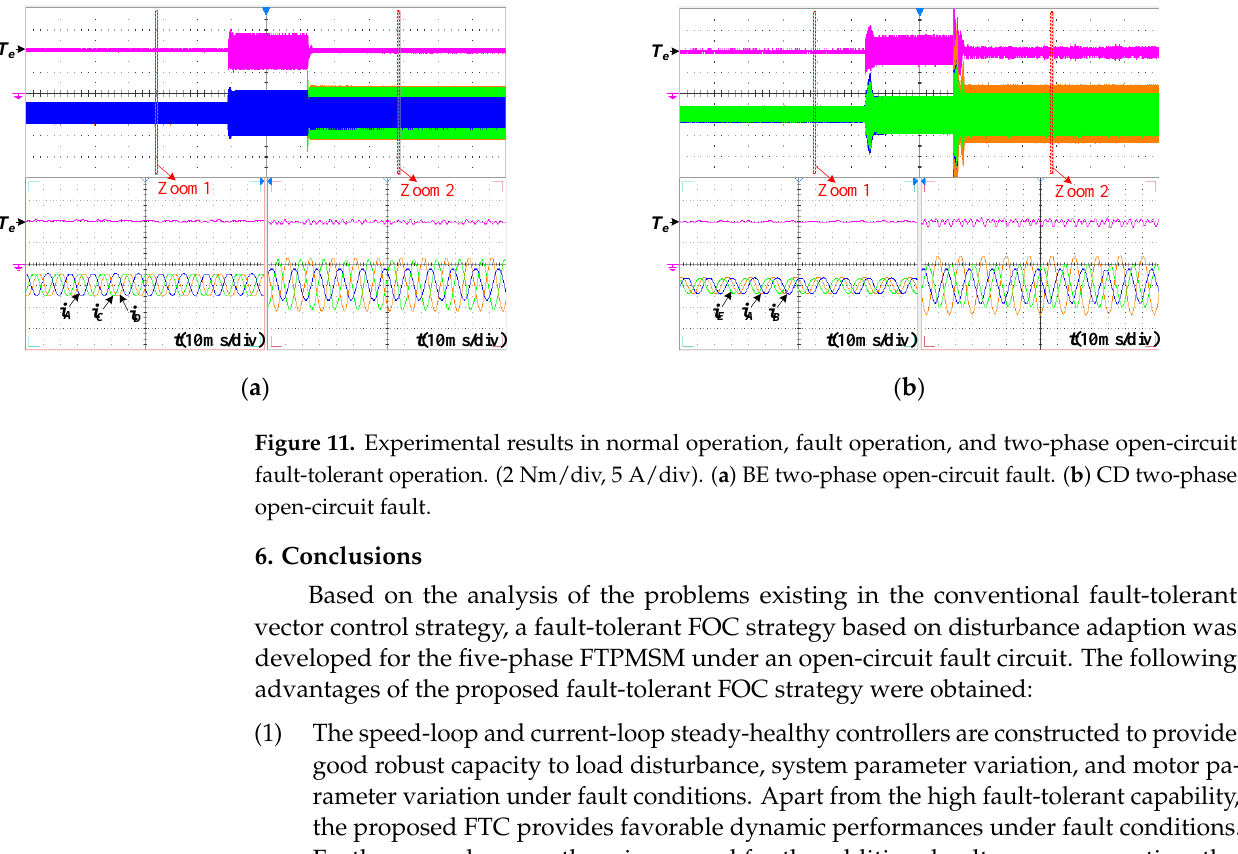
Figure 10. Dynamic responses with the reduced load at phase-A open-circuit fault-tolerant opera- tion. (500 rpm/div, 2 Nm/div, 5 A/div).